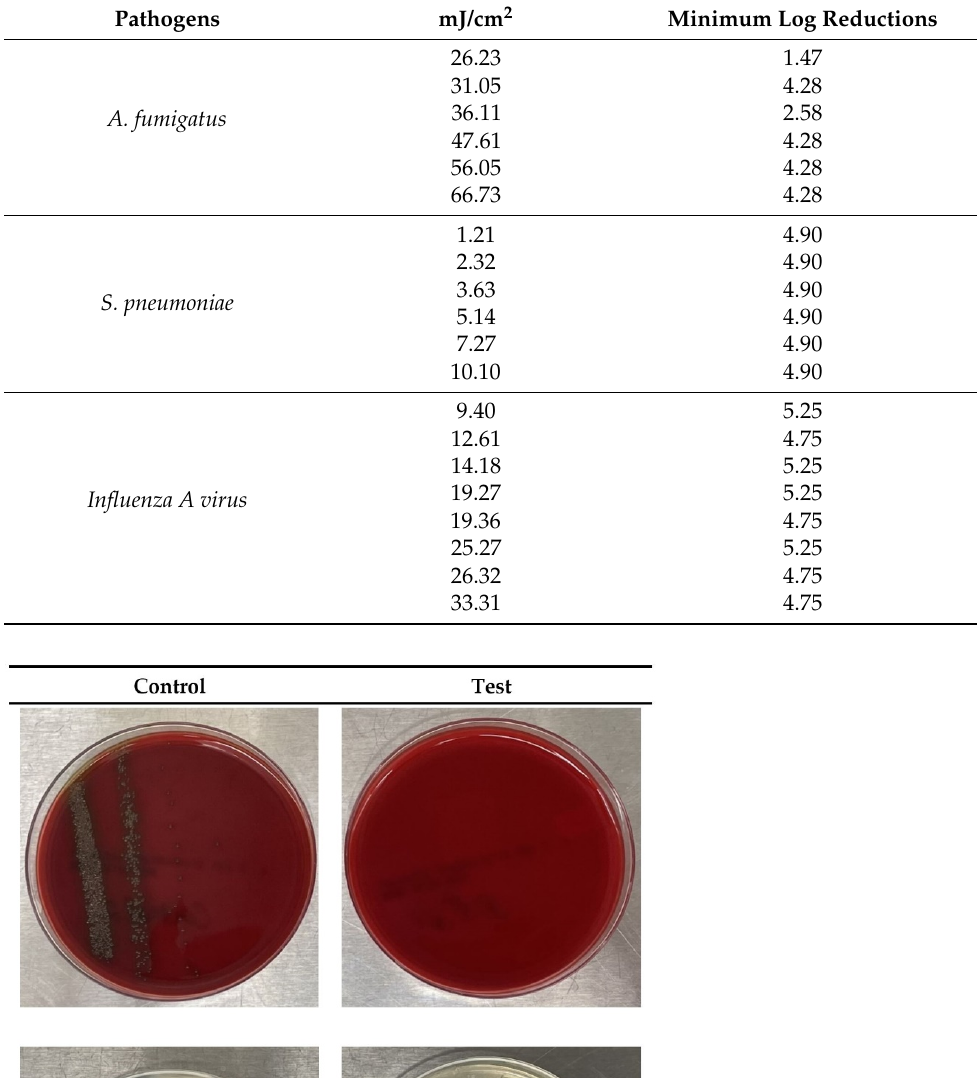
Table 1. CSI-D irradiation results.